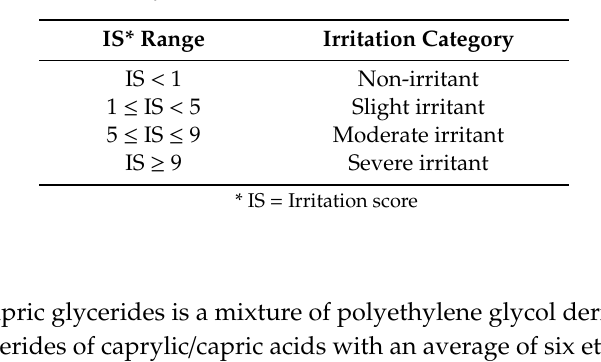
Irritation category according to the irritation score range evaluated by hen’s egg test-chorioallantoic membrane assay